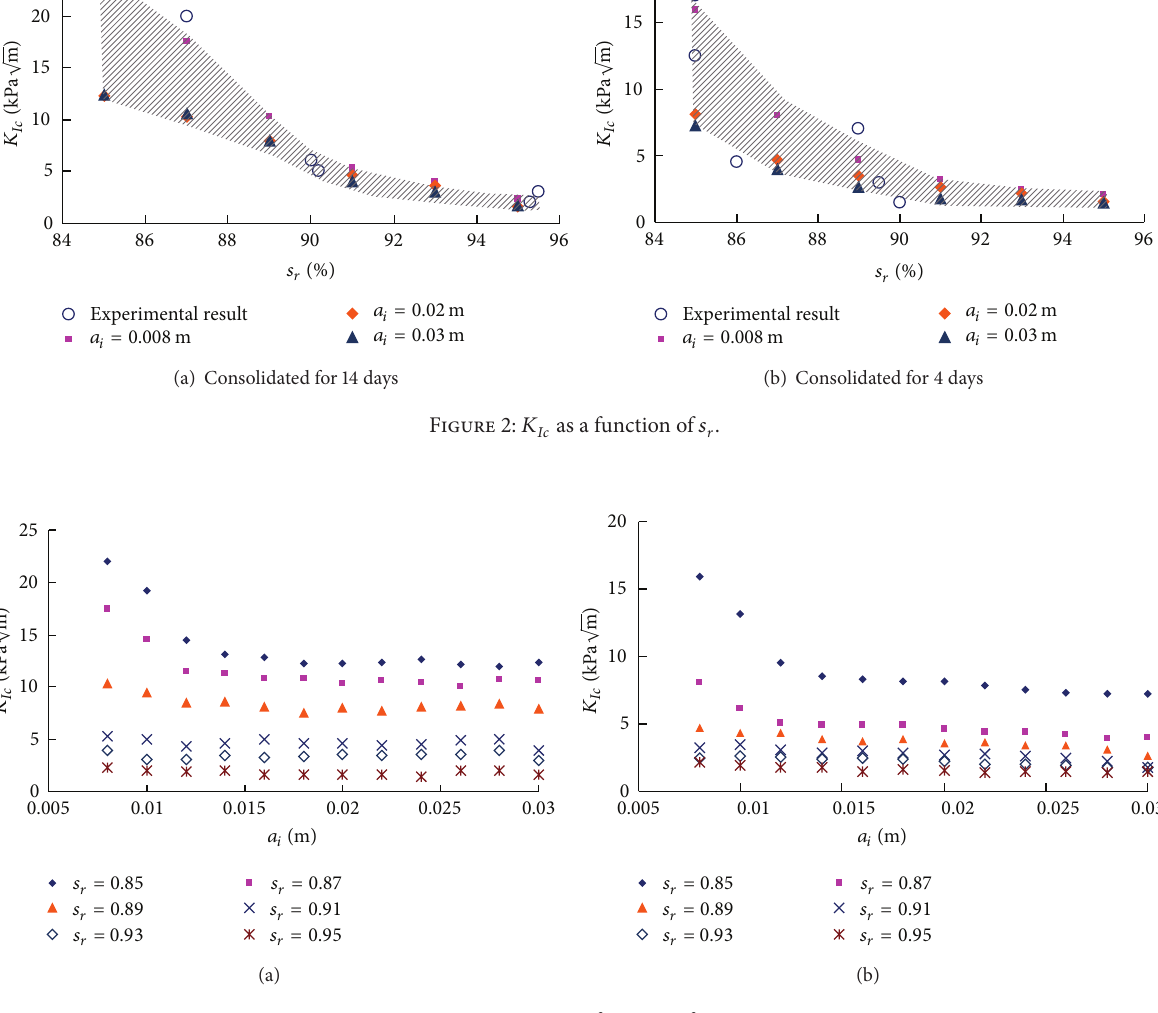
Figure 3: 𝐾 𝐼𝑐 as a function of 𝑎 𝑖